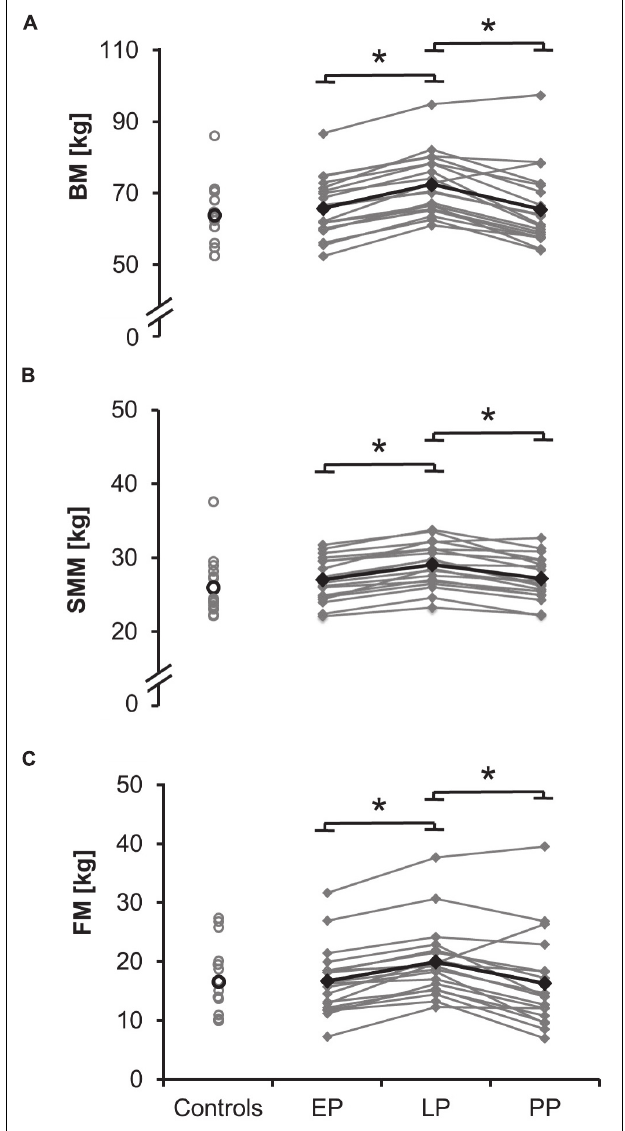
FIGURE 1 | Means (black) and individual data (gray) for body mass BM (A) , the skeletal muscle mass SMM (B) , and fat mass FM (C) for the non-pregnant controls and the pregnant women at the early (EP) and late (LP) stage of pregnancy as well as postpartum (PP) ( ∗ p < 0.05).